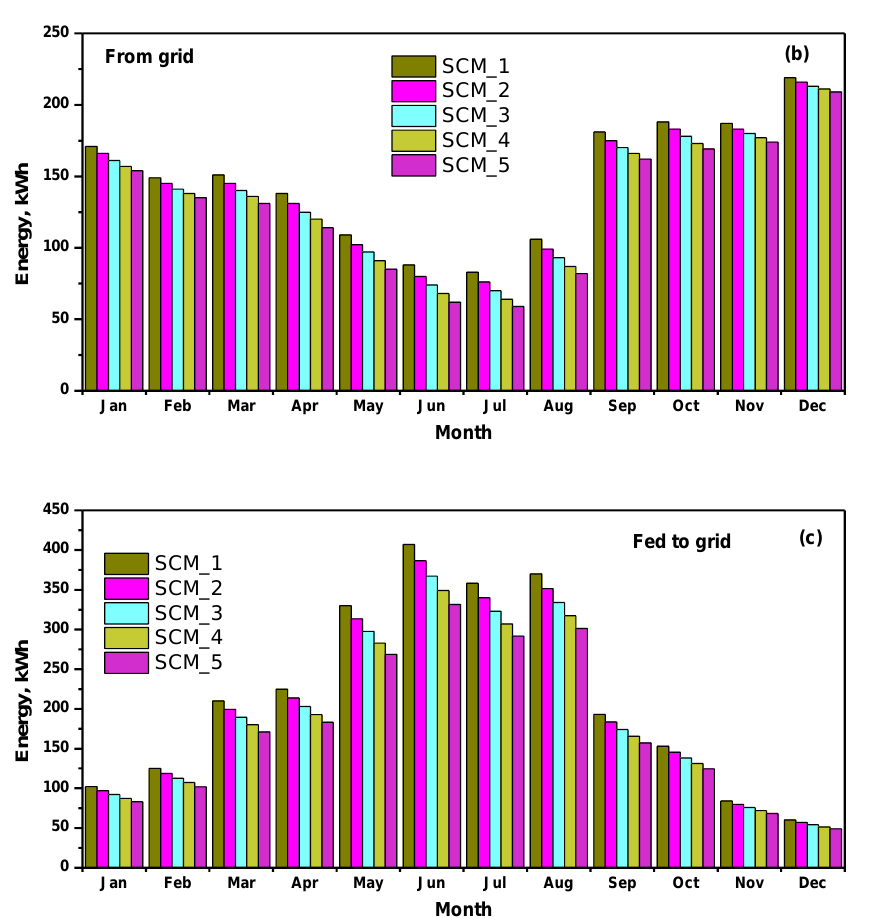
Figure 10. Monthly PV energy generation ( a ), energy taken from the grid ( b ), and energy fed to the grid ( c ).